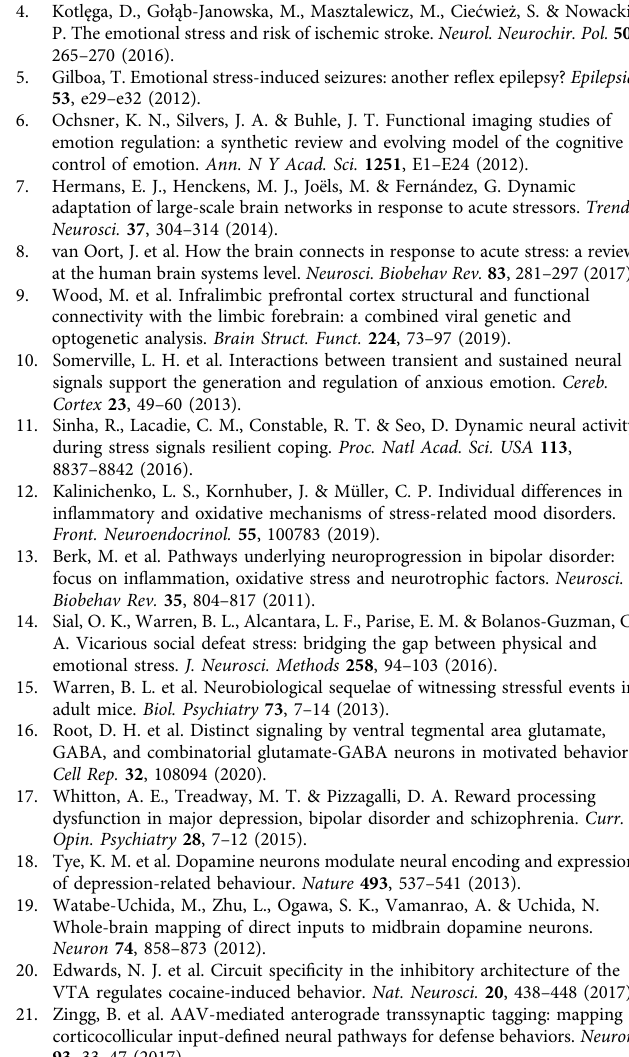
Fig. 8 Inhibition or activation of neural projection from NAc to VTA DA neurons could trigger or reverse the CES-induced anxiety-like behavior. a – i Inhibition of neural projection from NAc to the VTA DA neurons triggered anxiety-like behavior. a Schematic representation of in vivo virus infection and optical fi ber implantation. b Experimental scheme of virus injection and behavior tests. c – f Results of OFT ( n = 8 mice for each group). c Representative locomotion traces of NpHR or mCherry mice in OFT with laser on or off. d Percentage of time spent in the central area of OFT (two-way ANOVA, group: P = 0.0227, laser: P = 0.0477, interaction: P = 0.0104; post hoc Tukey ’ s test, NpHR(off vs. on): P = 0.0102, On(mCherry vs. NpHR): P = 0.0056). e Percentage of distance traveled in the central area of OFT (two-way ANOVA, group: P = 0.0255, laser: P = 0.0432, interaction: P = 0.0505; post